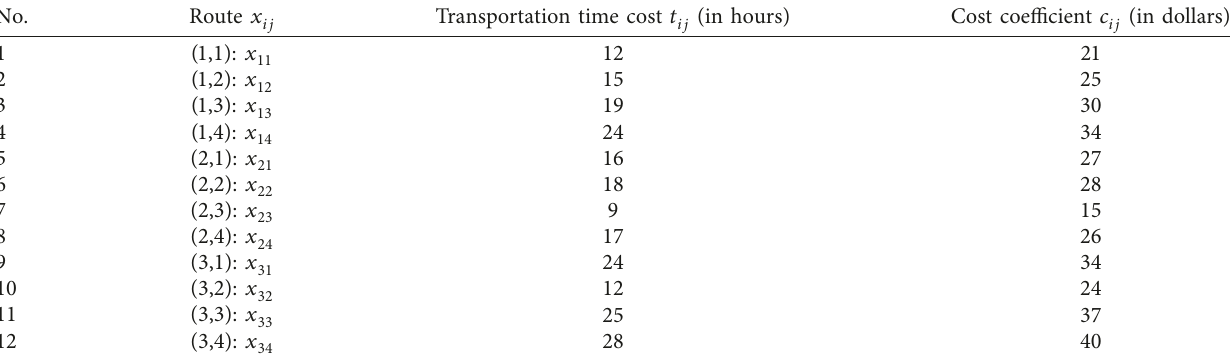
c ij and cost coefficient ij from each source to each destination.